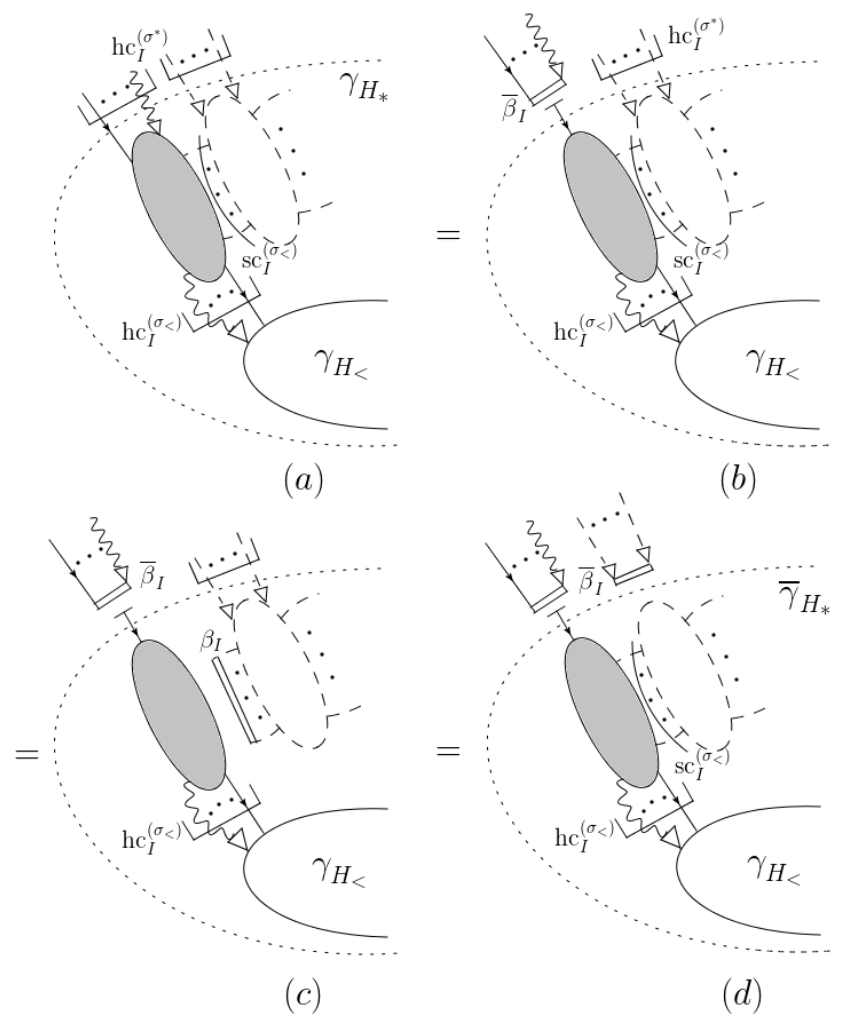
Figure 32. The graphic procedure to prove eq. (5.5). The (cid:12)gures ( b ) and ( c ) are the intermediate steps from ( a ) to ( d ), to obtain which we have repeatedly applied the Ward identity for factor- ization. The subgraph enclosed by the dotted curve is (cid:13) in ( a ), and becomes the reduced hard H (cid:3) subgraph (cid:13) in ( d ) after factorization. At (cid:27) < , some of its propagators become soft (represented H (cid:3) by dashed lines), some become lightlike (represented by the shadowed region), and some remains hard, which is (cid:13) H <